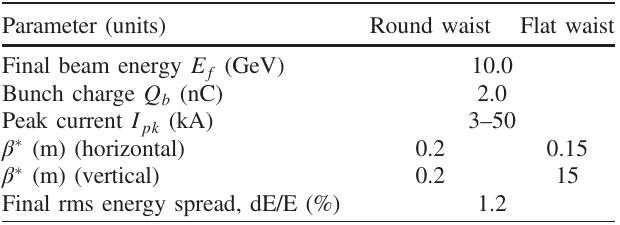
TABLE VI. Upstream (Kraken) waist parameters.